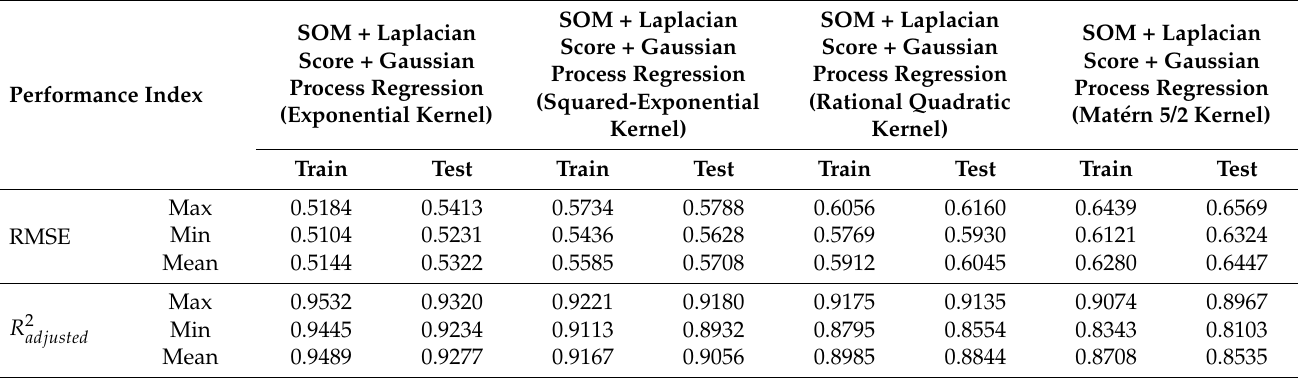
Table 4. Adjusted R 2 and RMSE results for Motor-UPDRS 0.9489 and 0.5144; 0.9516, 0.5105.